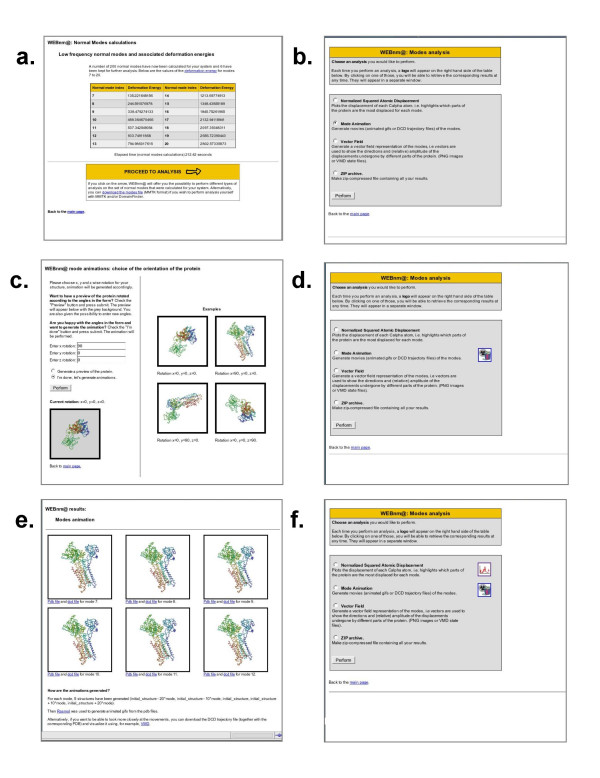
Snapshots of an example calculation of the SERCA1 Ca-ATPase. a. Presentation of the 10 lowest frequency modes with their average deformation energy. b. Page presenting the available analyses. c. Page where user can choose the orientation of the system for the animations. d. Apparition of an icon on the page presenting the list of analyses. e. Page displaying animated gif image of the first 6 modes (7 to 12). f. List of analyses page after that both mode animations and atomic displacements have been calculated, two icons are present.